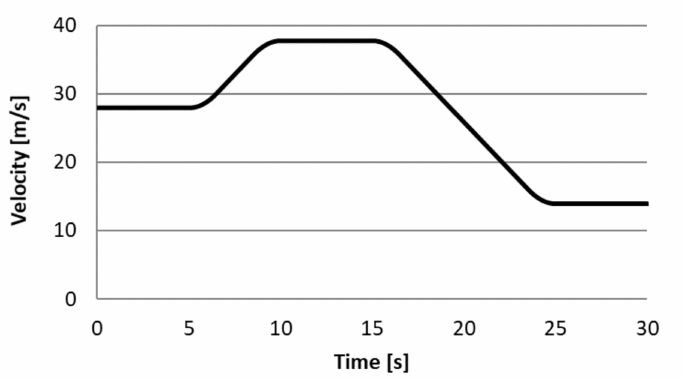
Figure 11. Present waveform of vehicle velocity.